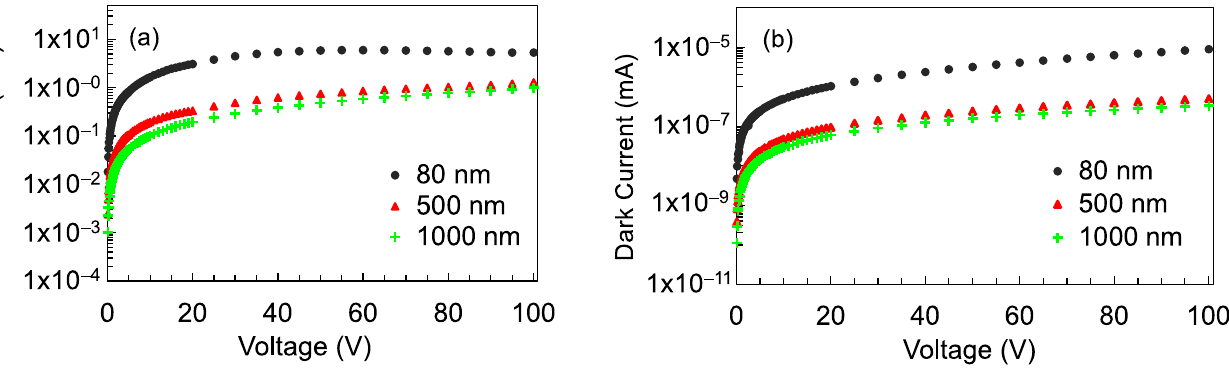
Figure 6. ( a ) I–V characteristics of the TiO 2 detectors under VUV illumination; ( b ) I–V characteristics of the detectors under darkness.